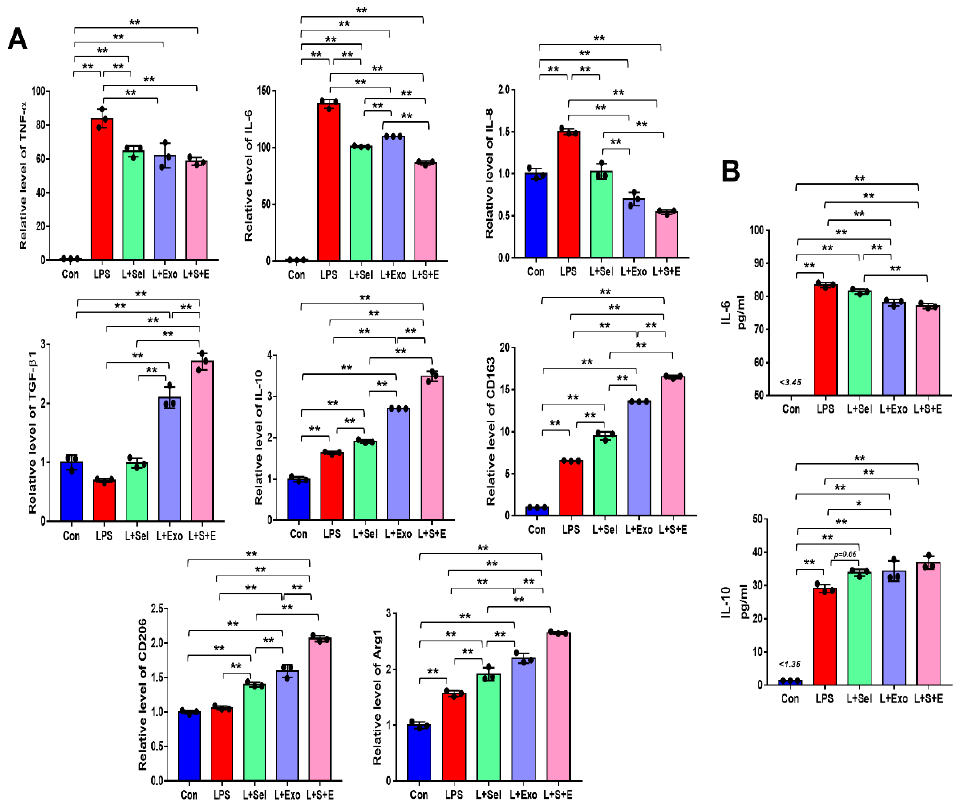
Figure 4. Effects of selenium, exosomes, and selenium-treated exosomes on the inflammatory response. ( A ) Relative gene expression related to pro-inflammation (TNF- α , IL-6, and IL-8) and anti- inflammation (TGF- β 1 and IL-10) was evaluated by real-time PCR after LPS treatment. Relative gene expression levels of CD163, CD206, and Arg1 were detected. ( B ) A multiplex assay was conducted to detect the concentrations of IL-6 and IL-10 in the conditioned media. Data are expressed as the mean ± SD of three independent experiments. * Significant difference from control, p < 0.05. ** Sig- nificant difference from control, p < 0.01.